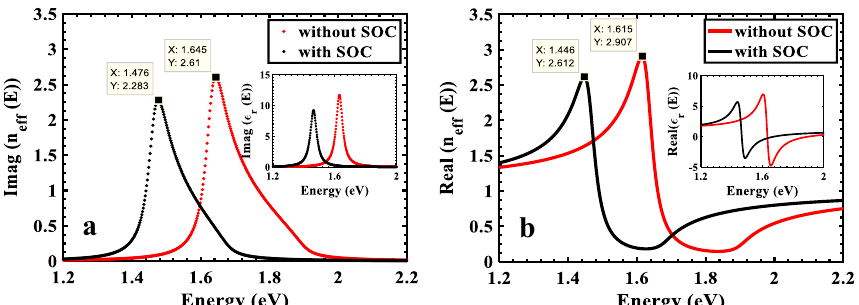
Figure 4. Comparison of the behavior of the ( a ) imaginary and ( b ) real parts of the effective refractive index of the TMDC-PSL with and without SOC. Insets show the real and imaginary parts of the dielectric